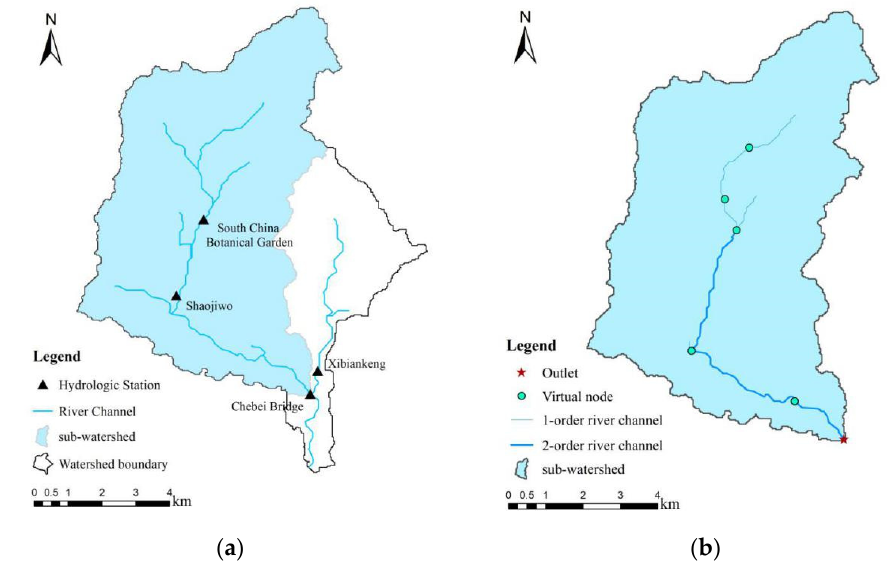
Figure 6. Liuxihe model structures in the Chebei Creek watershed. ( a ) Spatial location of the Chebei Creek sub-watershed; ( b ) model structure based on the Chebei Creek